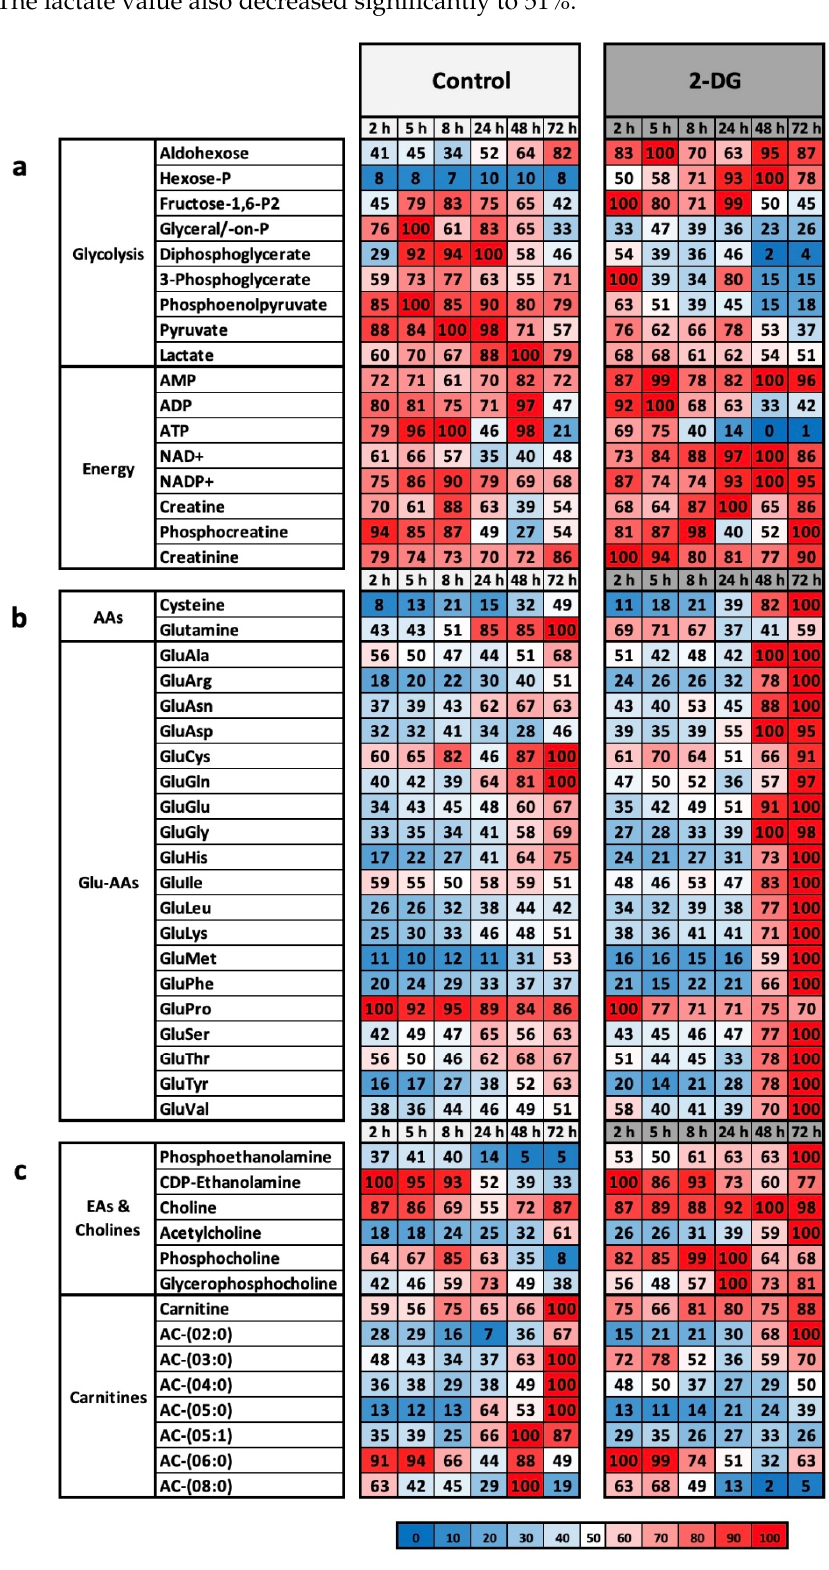
Figure 3. ( a – c ) Overview of metabolic classes and metabolic groups between control and 2-DG- stimulated cells. The metabolism of the murine cell line L929 was analysed via liquid chromatography mass spectrometry in complete medium (control) and with 625 µ M 2-DG. For each time point of